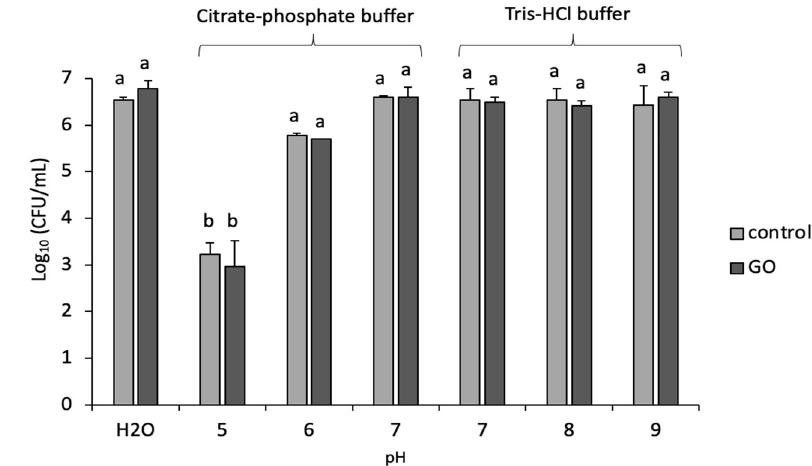
Figure 3. Impact of different pH values on P. putida planktonic cells ( a ) The viability of the pre ‐ treatment samples of planktonic cells after exposure to different pHs ( b ) The viability of the control samples (deionized water) or the post ‐ treatment samples (GO at 85 mg/mL) of planktonic cells after the exposure to a constant pH. Mean values with different letters are significantly different ( p < 0.05). Similar letters are non ‐ significantly different. The data were analyzed with one ‐ way ANOVA.